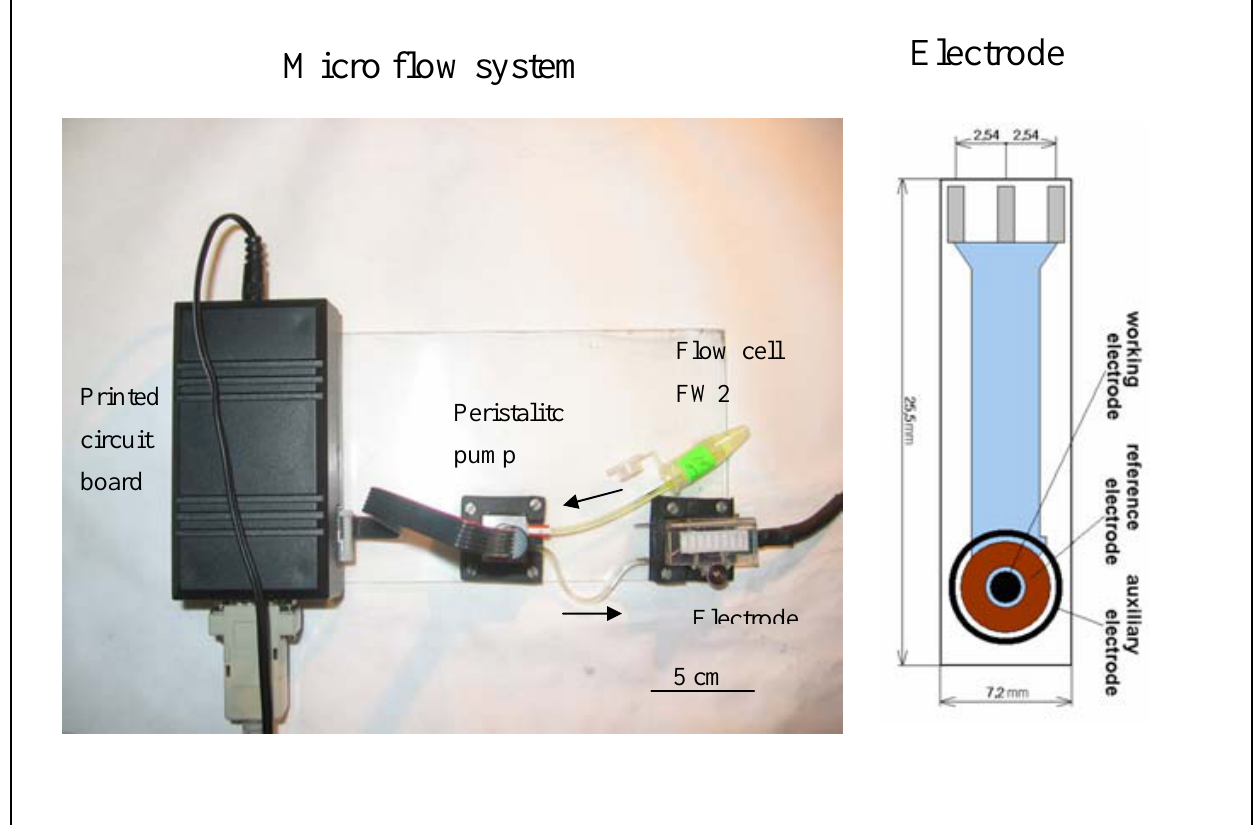
Figure 4. The photography of the micro flow system built from the micro pump, flow cell and printed circuit board. The scheme of the designed printed electrodes (working carbon, auxiliary carbon and referent Ag/AgCl